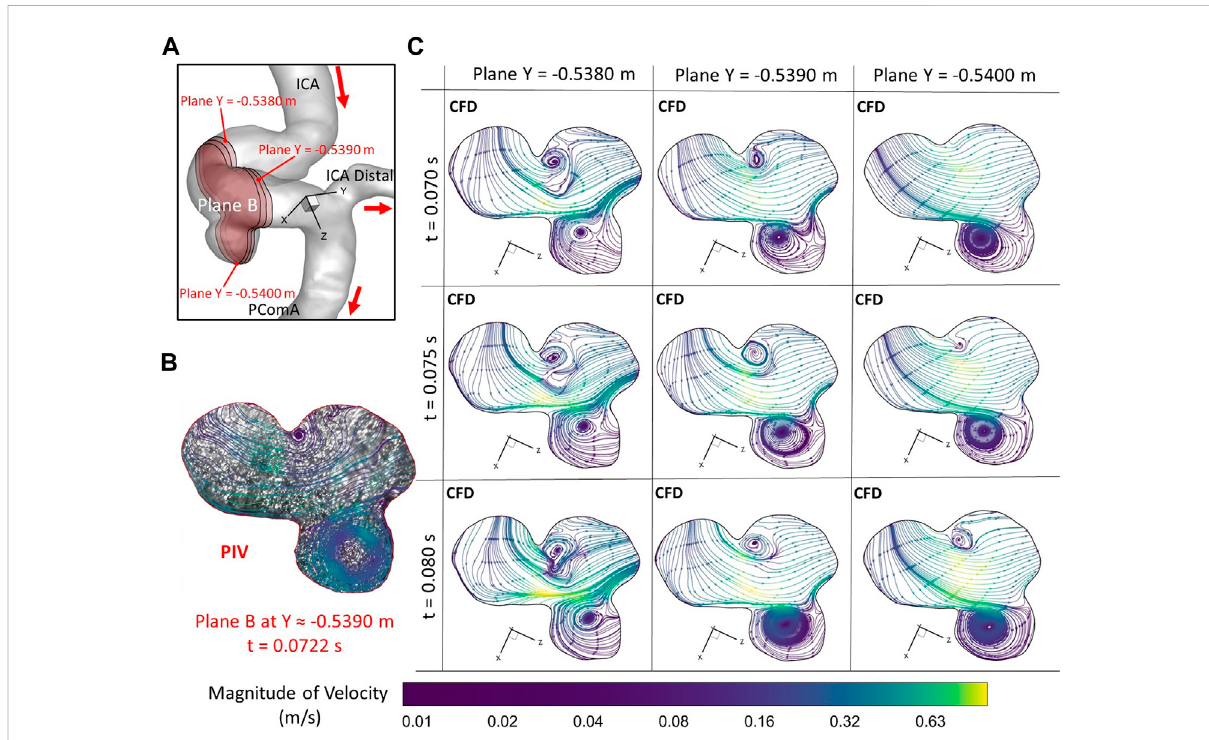
FIGURE 6 Comparisonsof fl ow streamlinesand magnitudes of velocity atthe extracted plane B (i.e., plane Y ≈ − 0.5390 m according to the coordinatesin CFD) between PIV measurements and CFD simulations at the time instant t = 0.078 s: (A) Schematic planes for the comparisons between PIV and CFD. (B) Distributions of fl ow streamlines and magnitudes of velocity in PIV. (C) Distributions of fl ow streamlines and magnitudes of velocity in